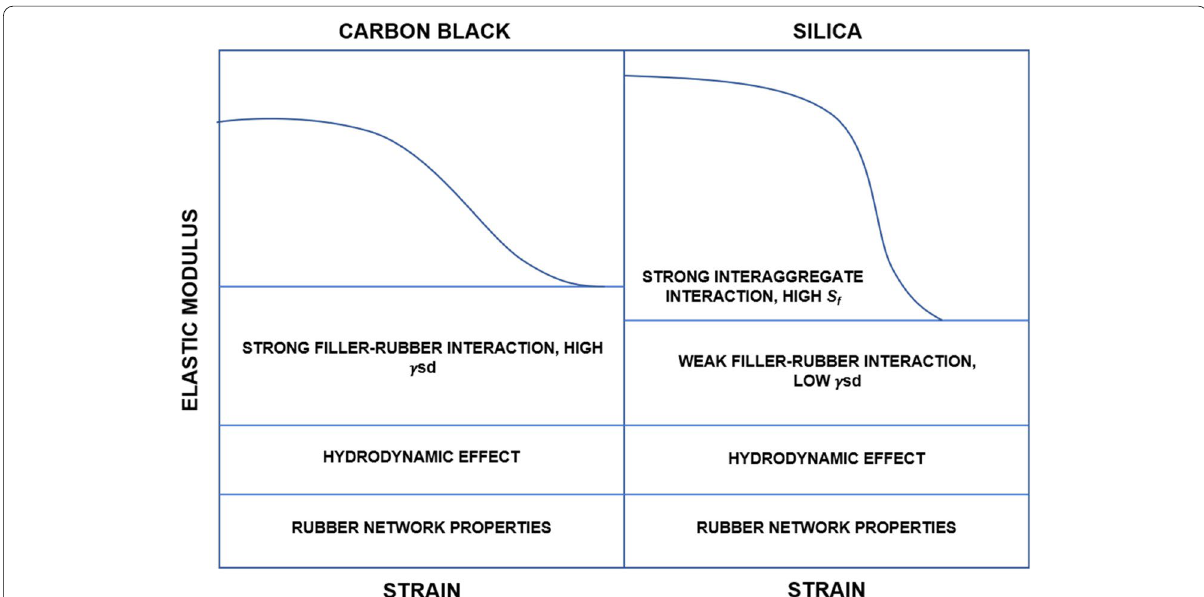
Fig. 3 Non‑Linear Strain dependency of elastic modulus of carbon black vs. silica‑filled elastomer composite. (γ sd means Dispersive component of surface energy)